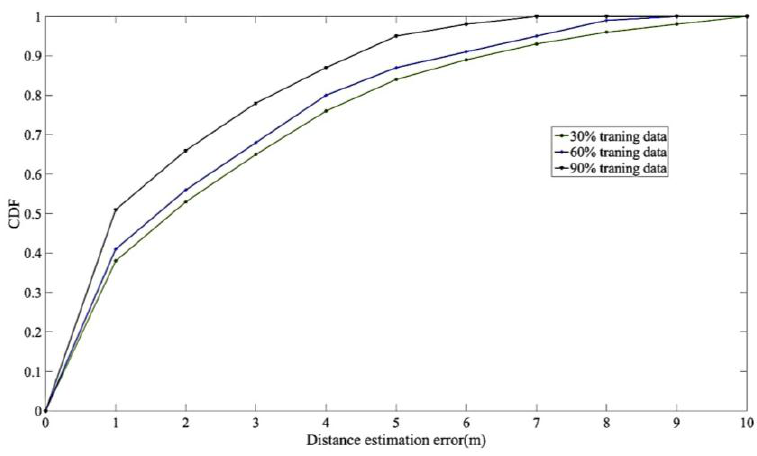
Figure 10. The field experiments on the different size of training samples.